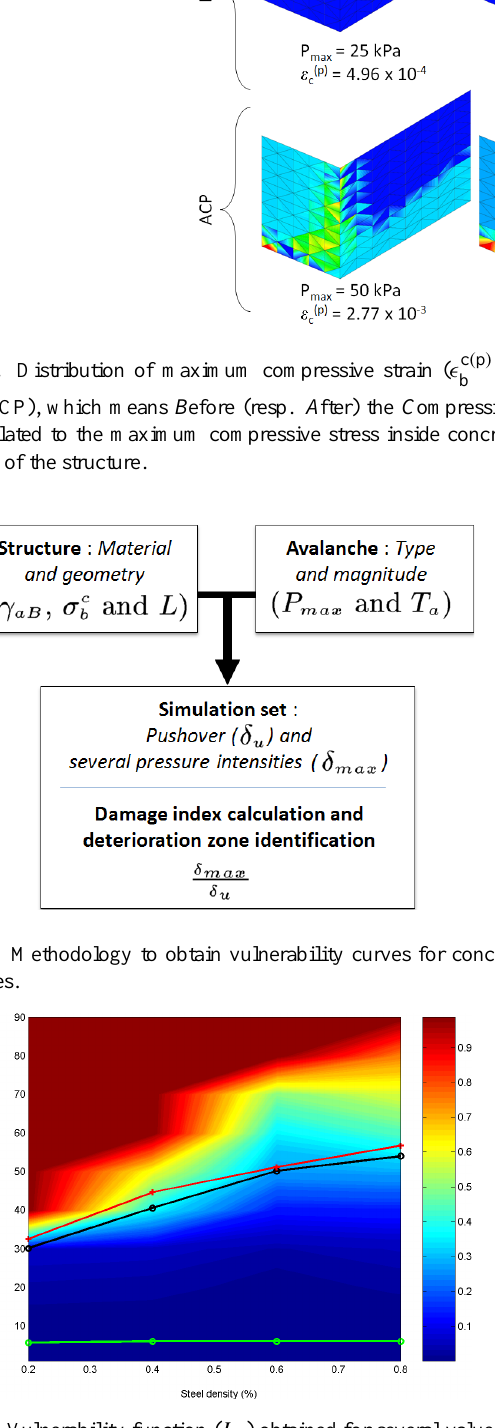
Fig. 18. Vulnerability function ( I D ) obtained for several values of wall width ( L